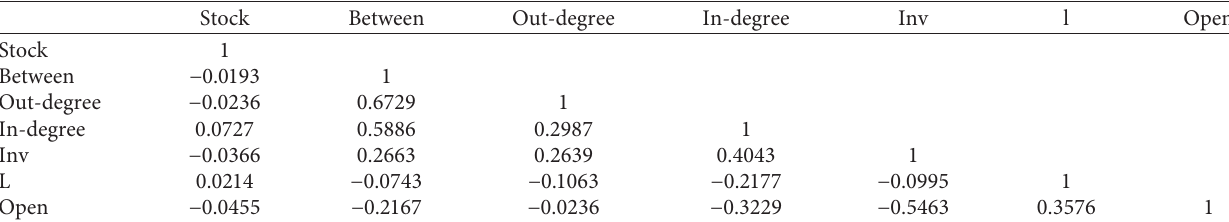
Table 2: Correlation matrix.